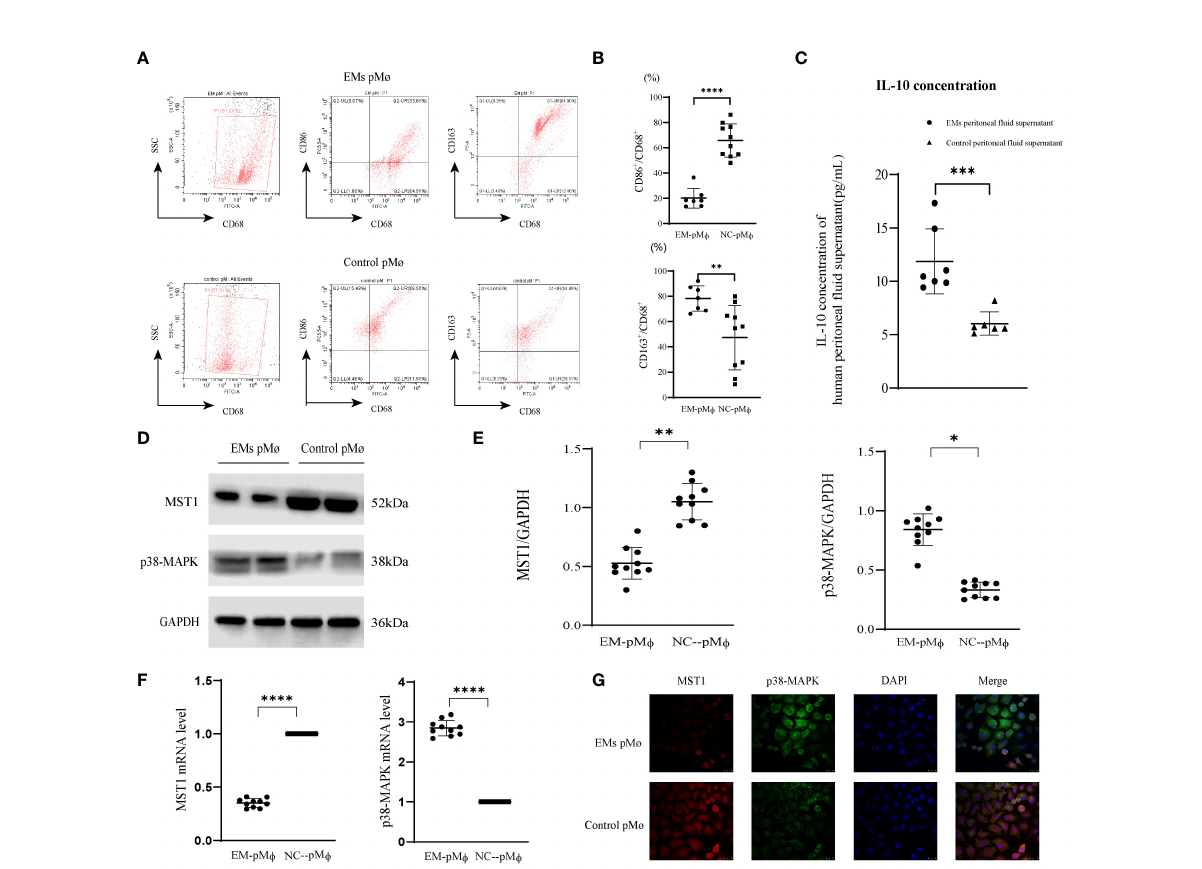
FIGURE 1 MST1 is downregulated in endometriosis-related peritoneal macrophages. (A, B) Intraperitoneal cells were collected from patients with or without endometriosis and then analyzed by fl ow cytometry. A higher percentage of CD68 + CD86 + macrophages was present in the peritoneal cavity of the control group, while the percentage of CD68 + CD163 + macrophages was higher in the peritoneal cavity of endometriosis patients. (C) The IL-10 concentration of human peritoneal fl uid supernatant with or without endometriosis. (D, E) Representative western blot of protein expression of MST1 , and p38-MAPK . (F) The mRNA level of MST1 and p38-MAPK by RT-qPCR. (G) The location of MST1 and p38-MAPK by immuno fl uorescence staining. *P < 0.05, **P < 0.01, ***P < 0.001, ****P < 0.0001 (Control group peritoneal macrophages vs. endometriosis group peritoneal macrophages). Values represent the mean ± standard